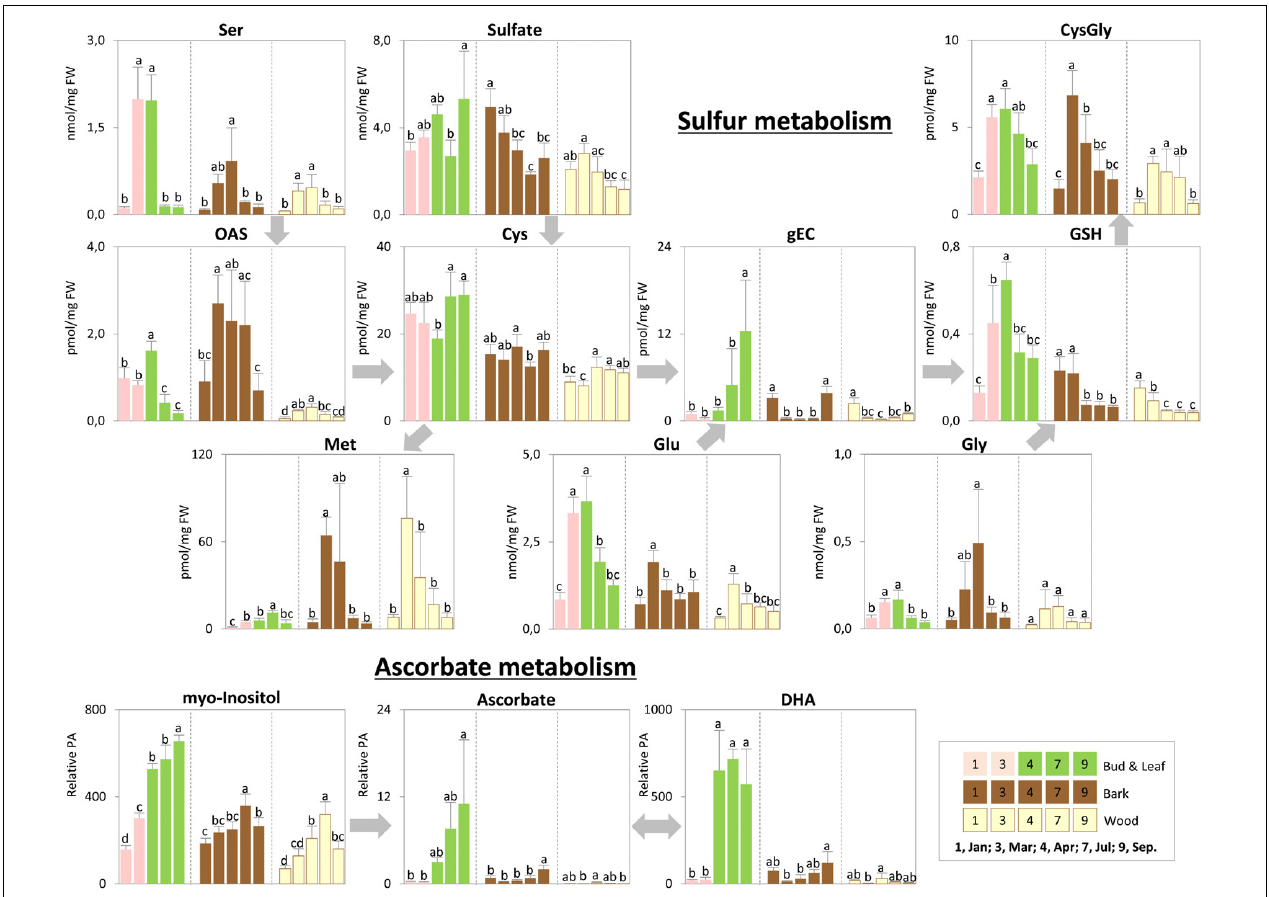
FIGURE 7 | Metabolic changes in sulfur and ascorbate metabolism. Changes of the selected metabolites in sulfur and ascorbate metabolism in poplar during annual growth. Data represent mean values of five biological replicates in each organ/tissue for each season. Error bars represent SD. Different letters represent statistically significant differences ( P < 0.05) between seasons in each organ/tissue using Tukey’s test ( Supplementary Table S2 ). Relative PA, relative peak area; OAS, O -acetylserine; gEC, gamma-glutamylcysteine; GSH, glutathione; DHA,